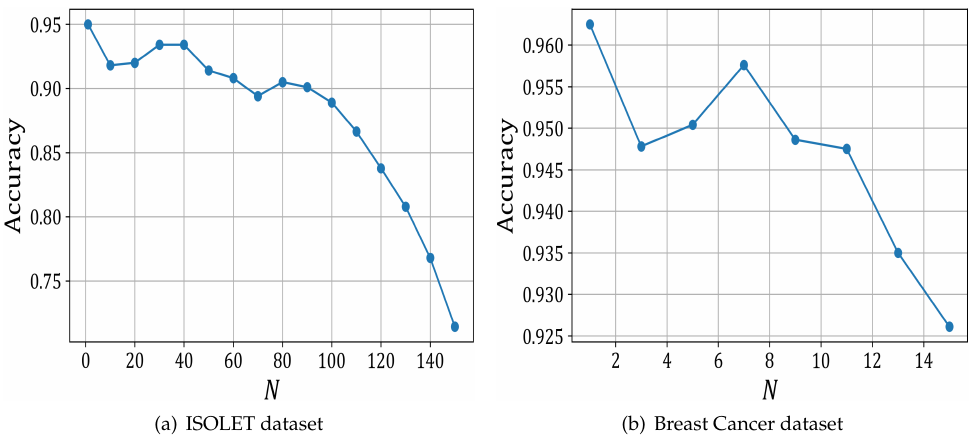
Figure 2. The accuracy of the vertically federated learning varies with the number of organizations on different